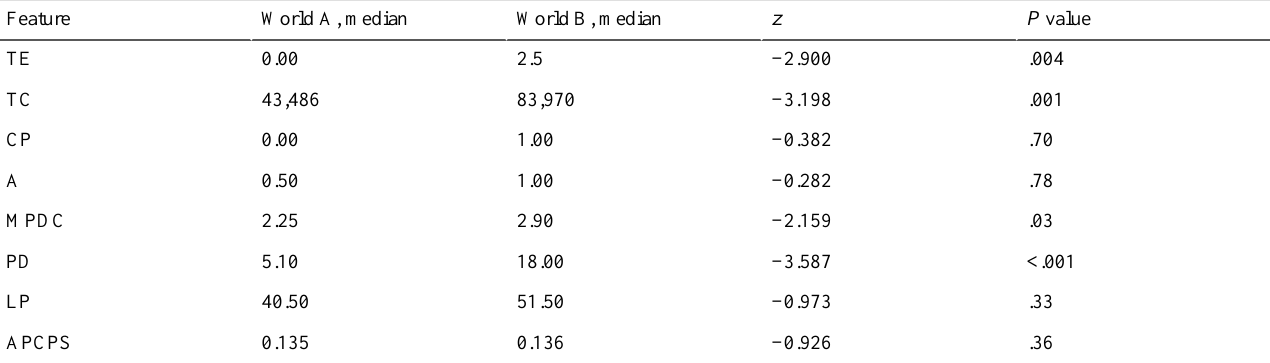
Table 4. Median values for pupillary and gamer measurements, and the Wilcoxon signed rank